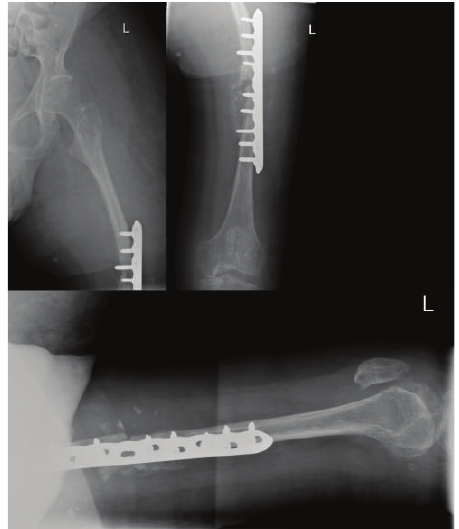
Figure 4: AP and lateral radiograph of the left femur immediately after open reduction, internal fixation.